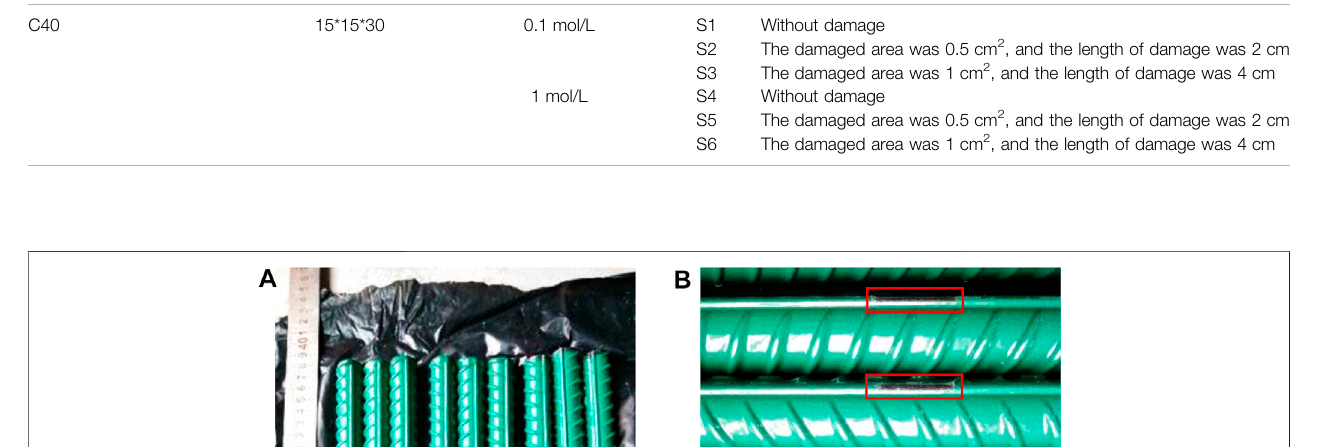
Frontiers in Materials |